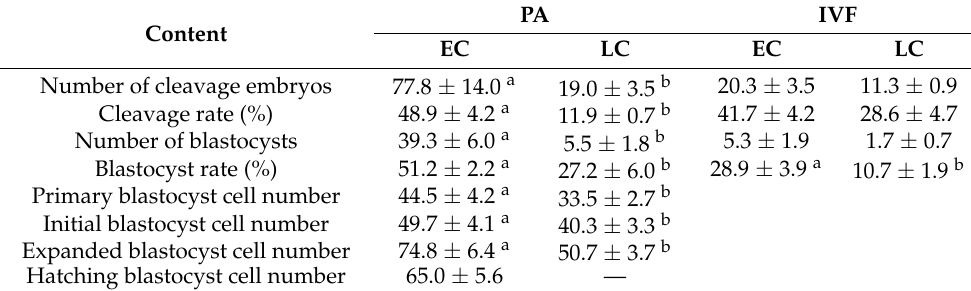
Figure 1. Cleavage and blastocyst rate of embryos cleaved at different times after parthenogenetic activation (PA) or in vitro fertilization (IVF) with four repetitions. ( A ) Cleavage rate of porcine PA and IVF embryos. ( B ) Blastocyst rate of porcine PA and IVF embryos. Table 2. Development efficiency of early and late cleavage of porcine PA and IVF embryos.